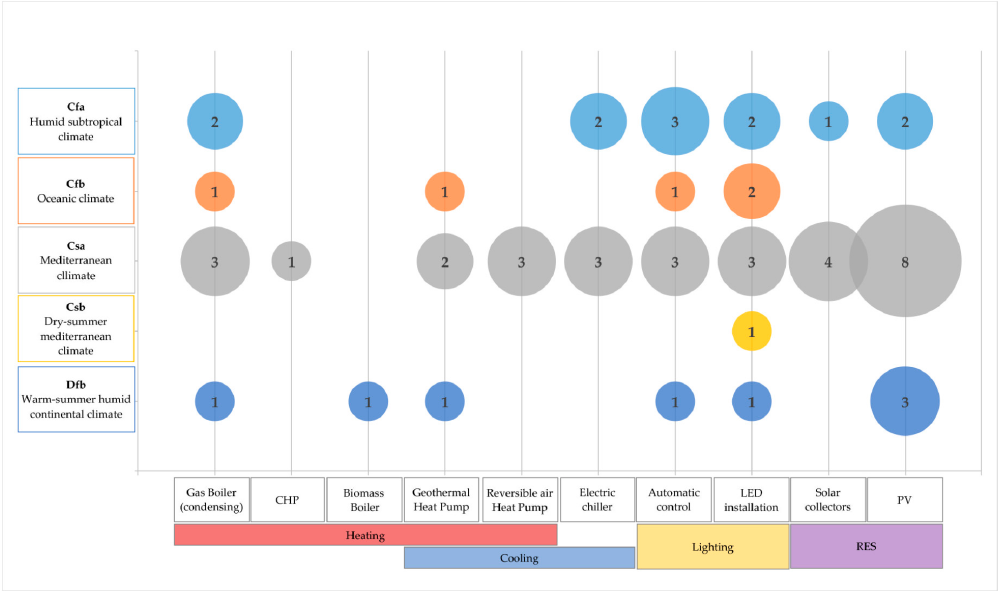
Figure 22. Optimal EEMs for energy systems—non-residential buildings.